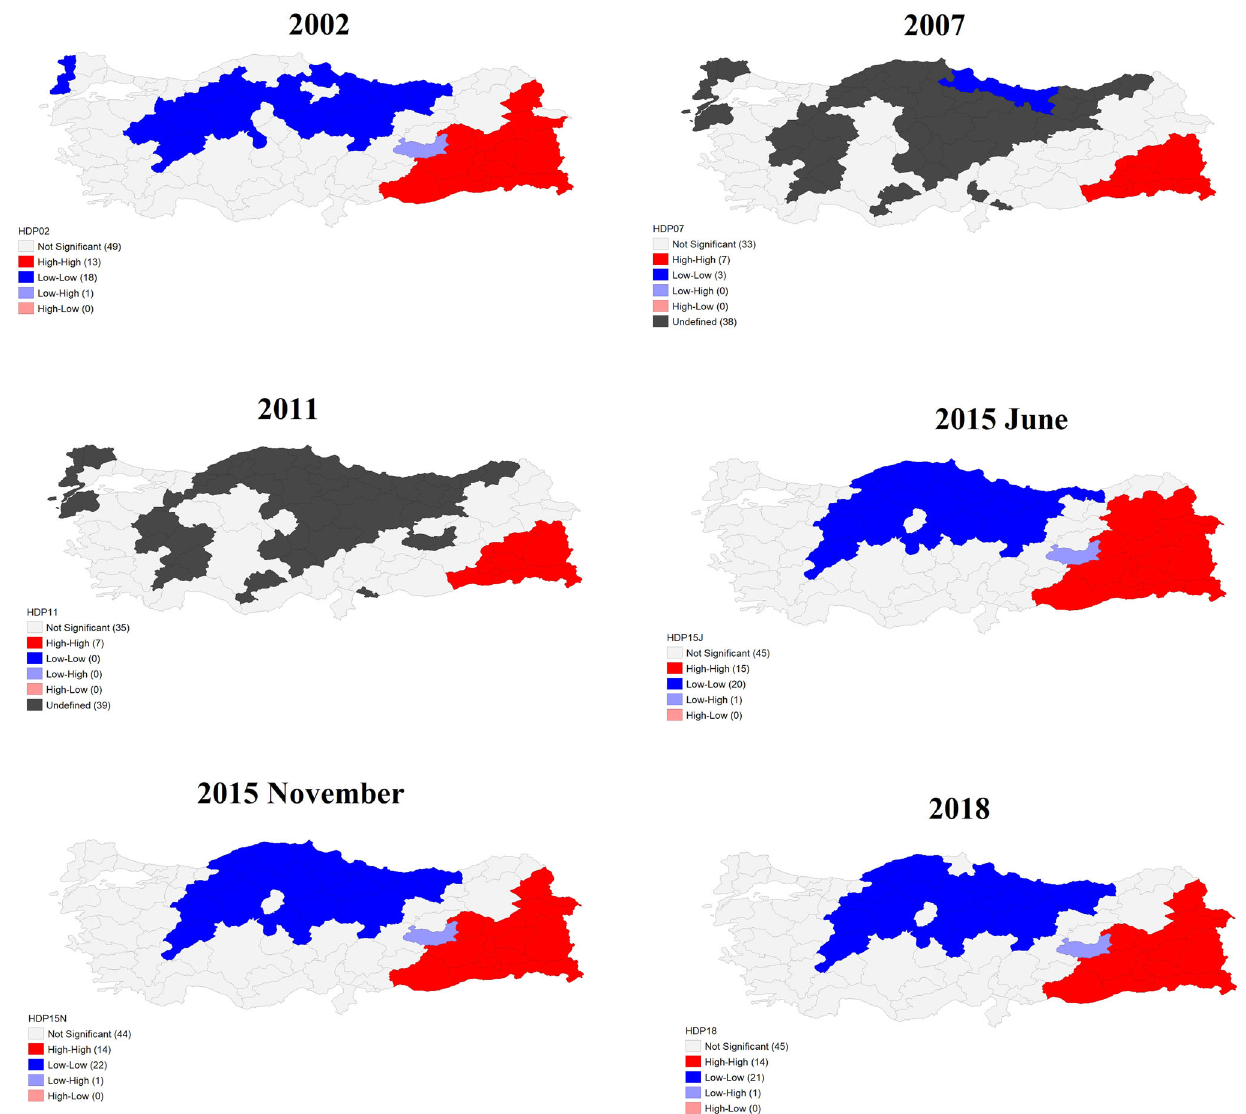
Fig. 5 LISA maps for Pro-Kurdish parties. LISA maps have been obtained via queen